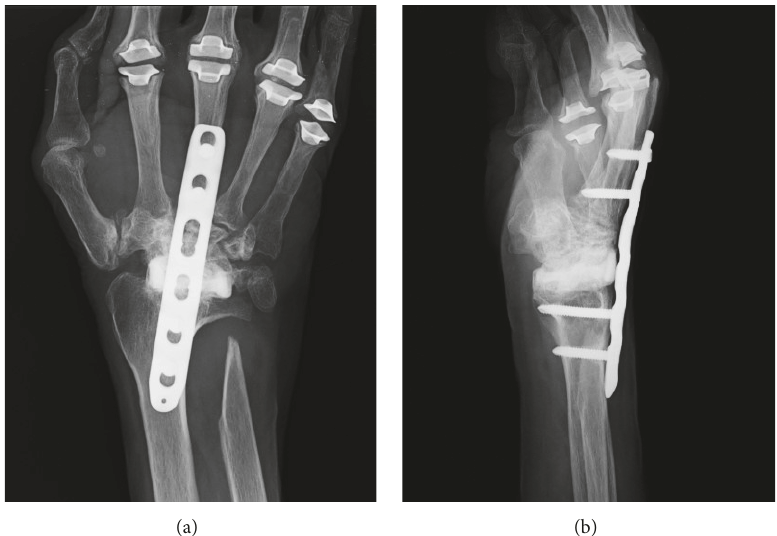
Figure 3: Representative anteroposterior (a) and lateral (b) radiographs of wrist arthrodesis using LCP metaphyseal